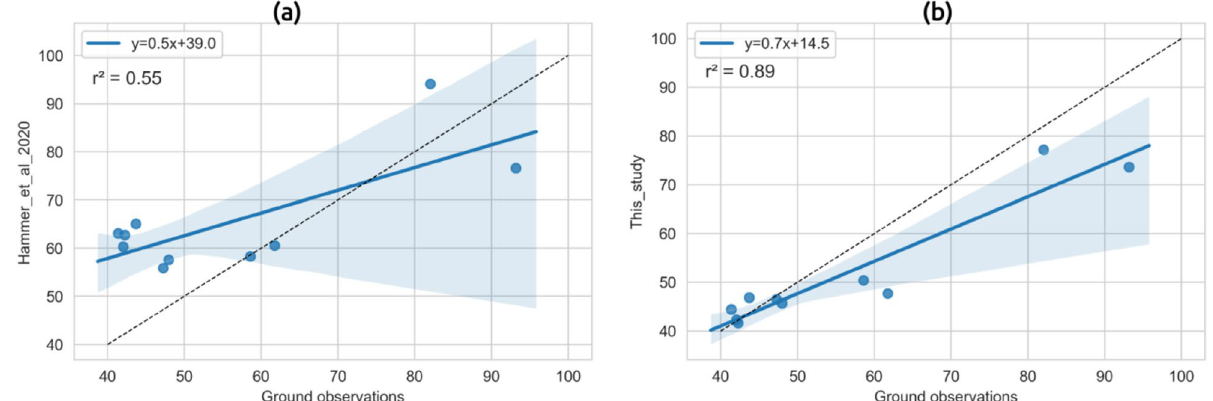
Figure 7. Scatter plots between model derived annual mean concentration of daily surface PM 2.5 and ground observations ( a ) Hammer et al. 27 model and ( b ) the model used in this study. The black dashed line shows x = y and the translucent band represents 95%